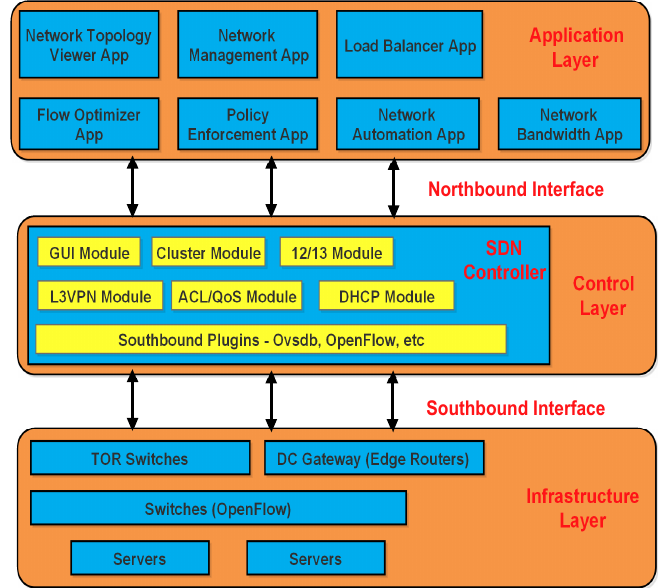
Figure 1. The General Architecture of Software Defined Network (SDN)